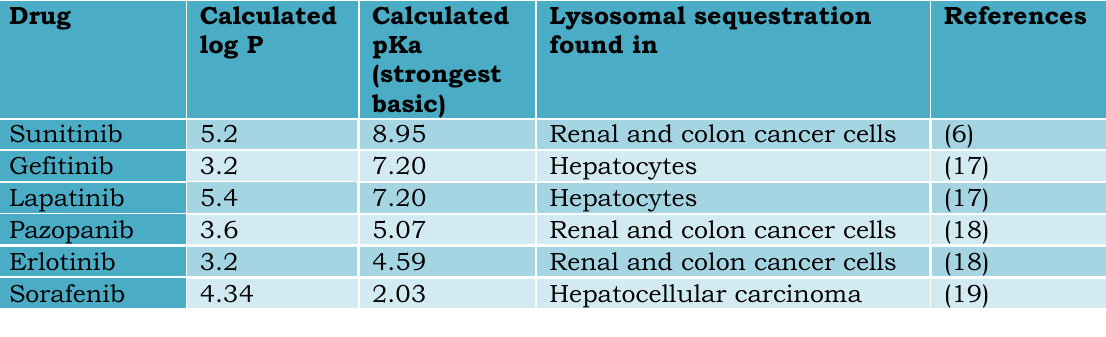
Table 1. Lysosomal sequestration of TKIs in several different cell lines